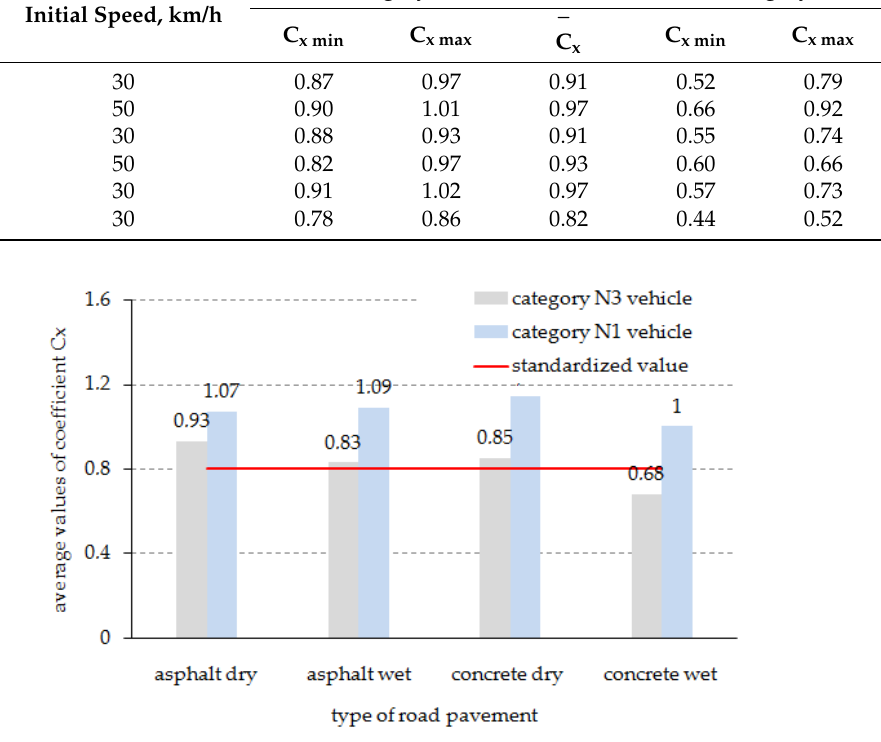
Figure 6. Average values of coefficient C x established for maximum deceleration values registered during braking tests with an initial speed of 30 km/h.